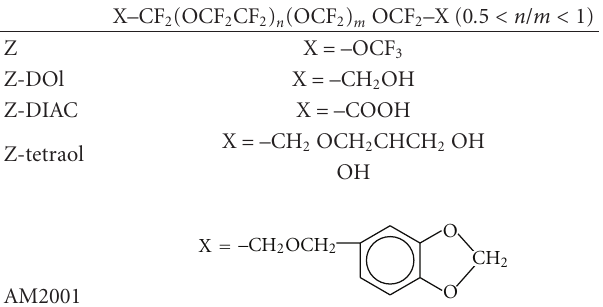
Table 1: Functionalized PFPE lubricants